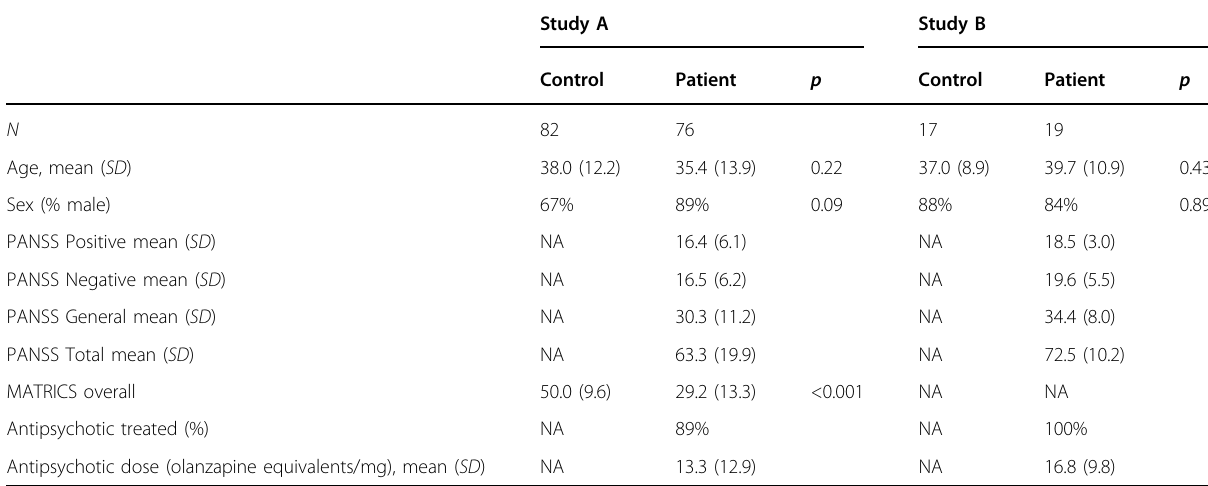
Table 1 Demographic details of study